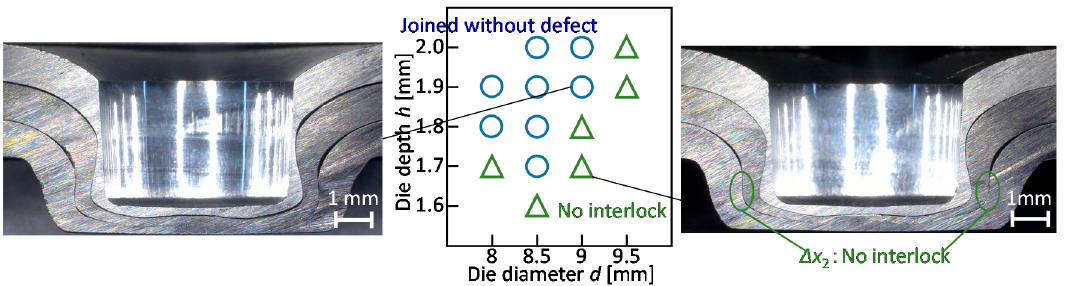
Figure 19. Joining range for 980 MPa steel sheets and without adhesive.